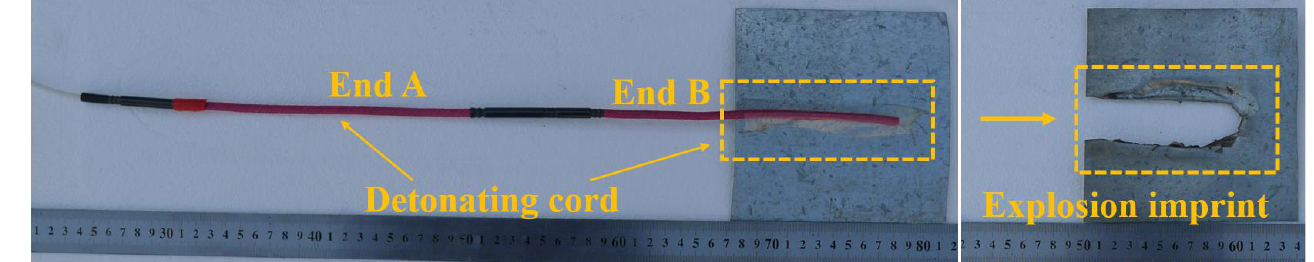
Figure 5. Successful detonation propagation experiments. Table 3. Detonation propagation results using different design parameters. Core Load of the Detonating Cord (End A) (g/m)